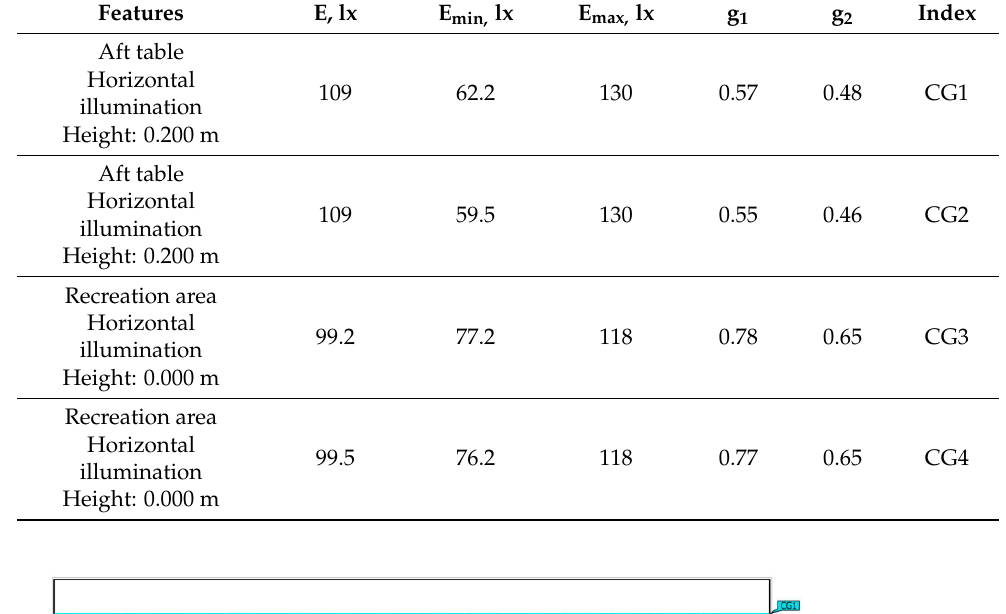
Table 1. Calculated surfaces.